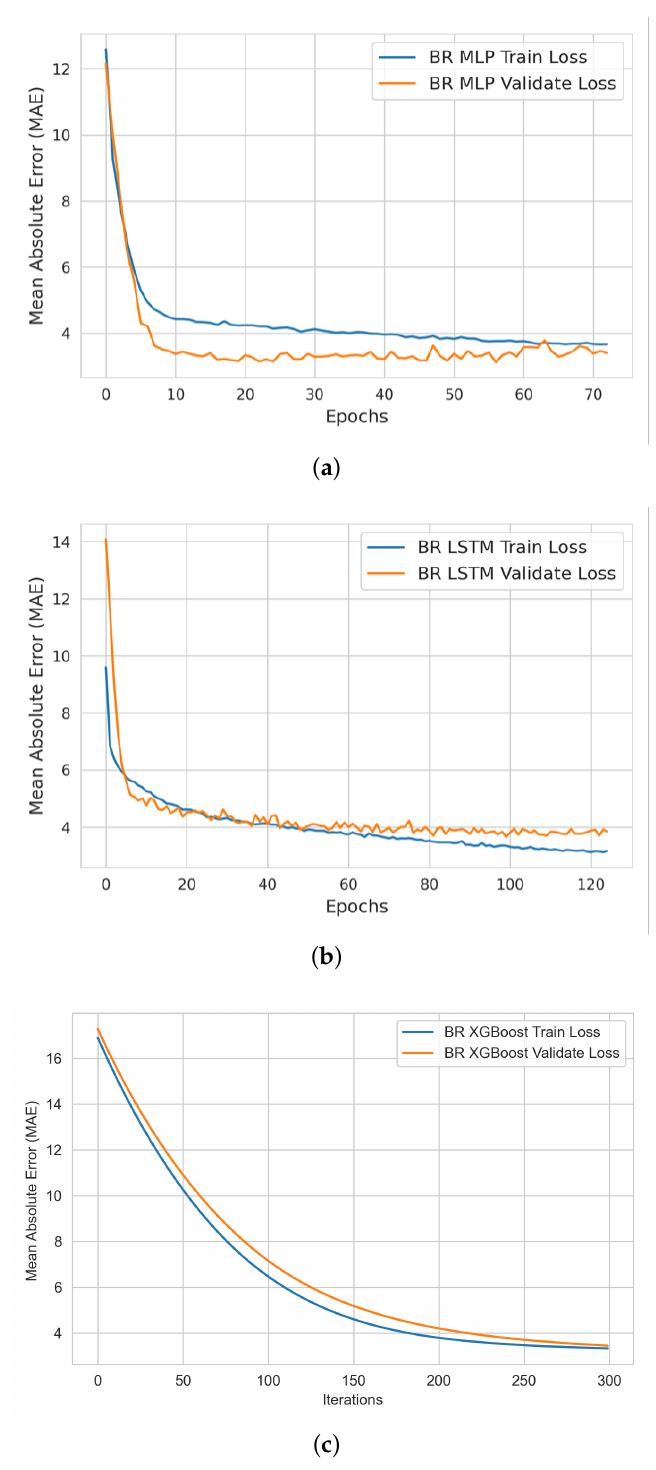
Figure 7. Breathing rate ML models’ performance curves during learning and validation of ( a ) MLP ( b ) LSTM and ( c ) XGBoost